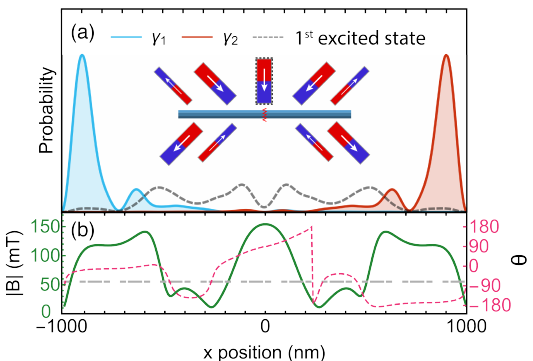
Figure 4: (a) Probability distributions of two lowest energy states for double Dragon- / ∆ = 5.1 × 10 − 4 . fly setup with gate open (shown in inset). MZM (red / blue) with E 0 / ∆ = 1.6 × 10 − 1 . External field of 40mT The first excited state (grey dashed) with E 1 is applied in positive y-direction. Inset: two dragonfly configurations, with zigzag indicating an electrostatic gate capable of dividing the nanowire in two parts. (b) Magnetic field profile along the wire, showing amplitude (solid) and angle